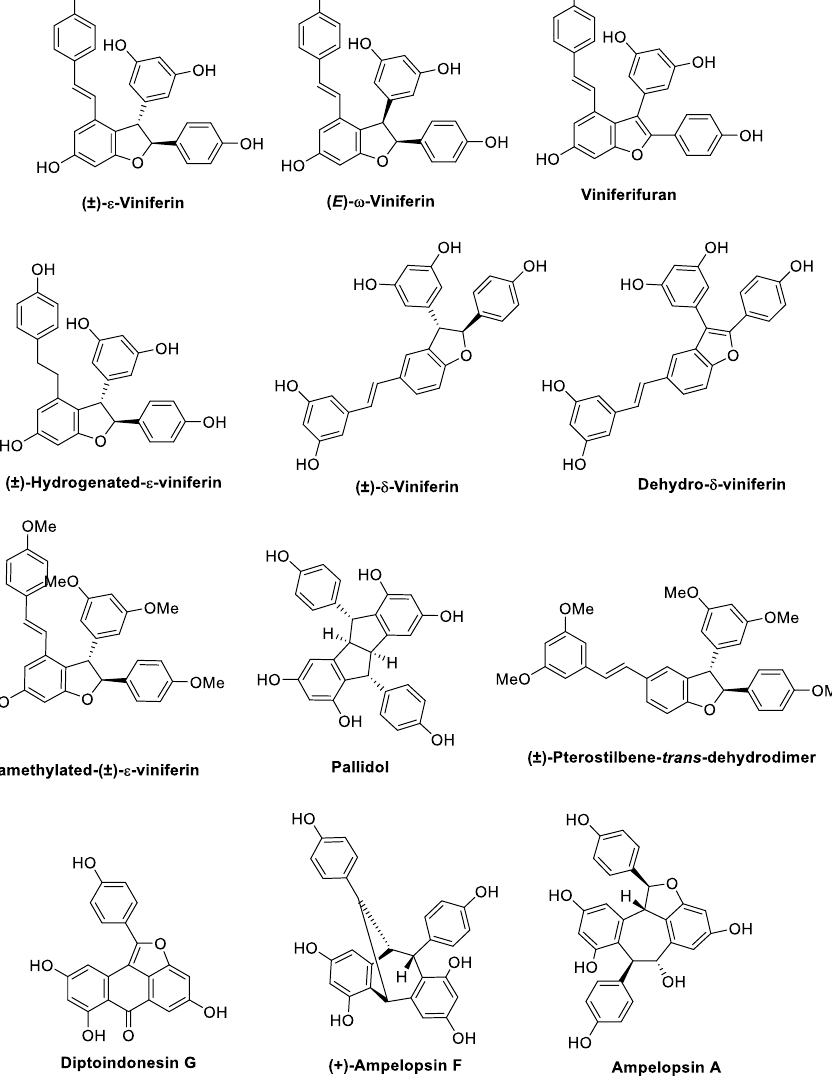
Figure 16. Structures of oligomeric stilbenoids from Shen et al. (2009) [32], Keylor et al. (2015) [100], and Sáez et al. (2018) [101].